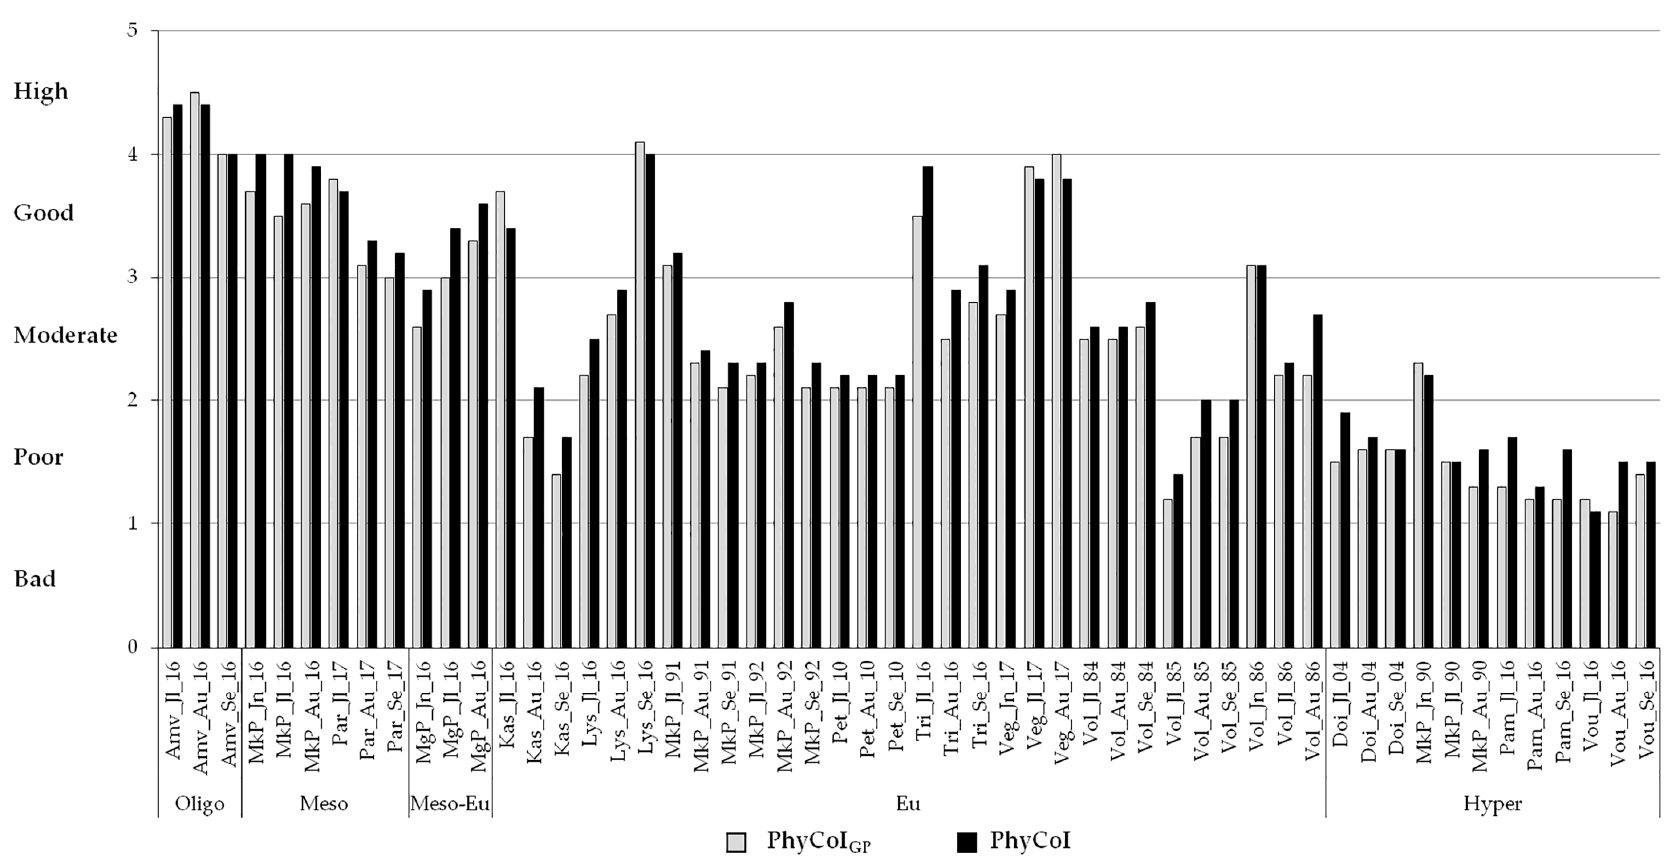
Figure 4. PhyCoI (black) and PhyCoI GP (grey) values for the studied lakes in the various sampling dates (lake abbreviations according to Table 1 followed by month and year of sampling).